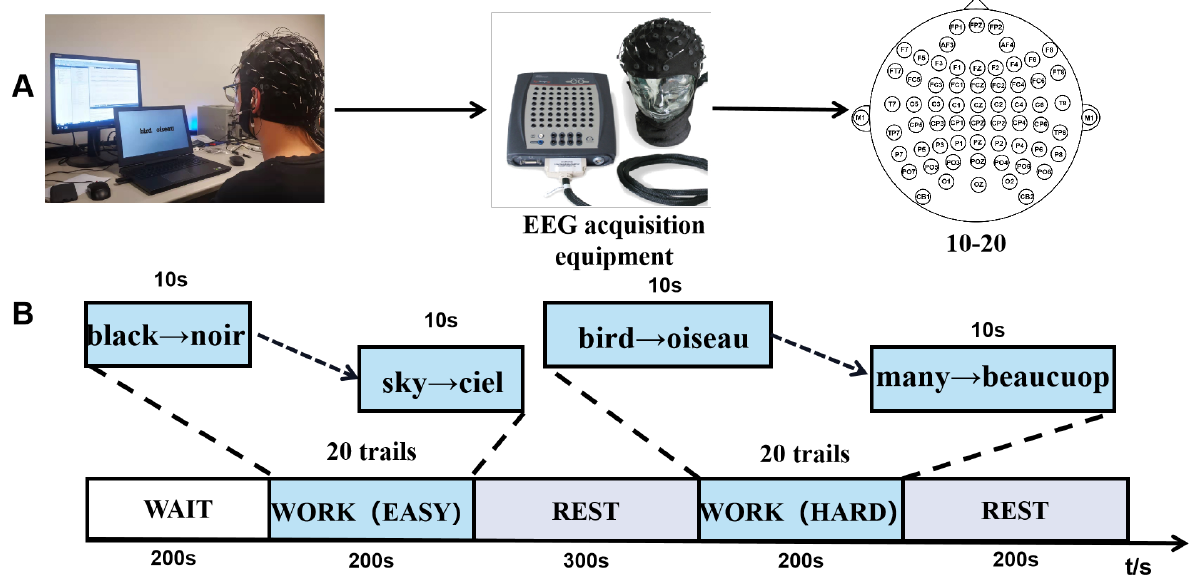
Figure 1. The working memory paradigm. ( A ) The EEG acquisition equipment. The electrode cap con- forms to the international 10–20 standard. ( B ) Working memory experimental paradigm framework. The French word from the easy and hardworking memory task, are selected based on the recommendations of linguists to make sure the subjects experience a different working memory